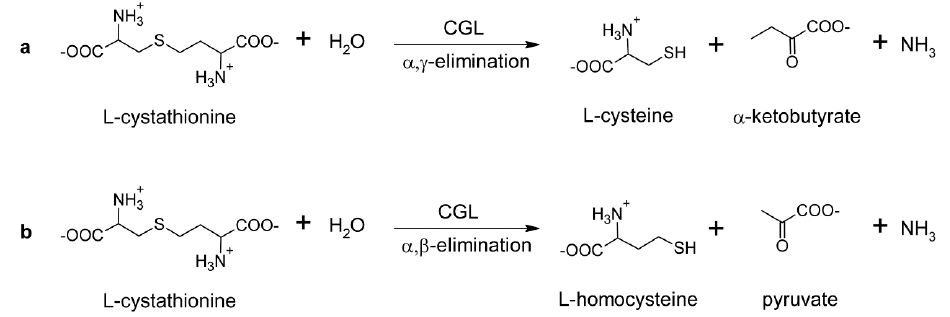
Figure 3. Overview of the α , γ - ( a ) versus α , β -elimination ( b ) reactions of L-cth catalyzed by CGL.